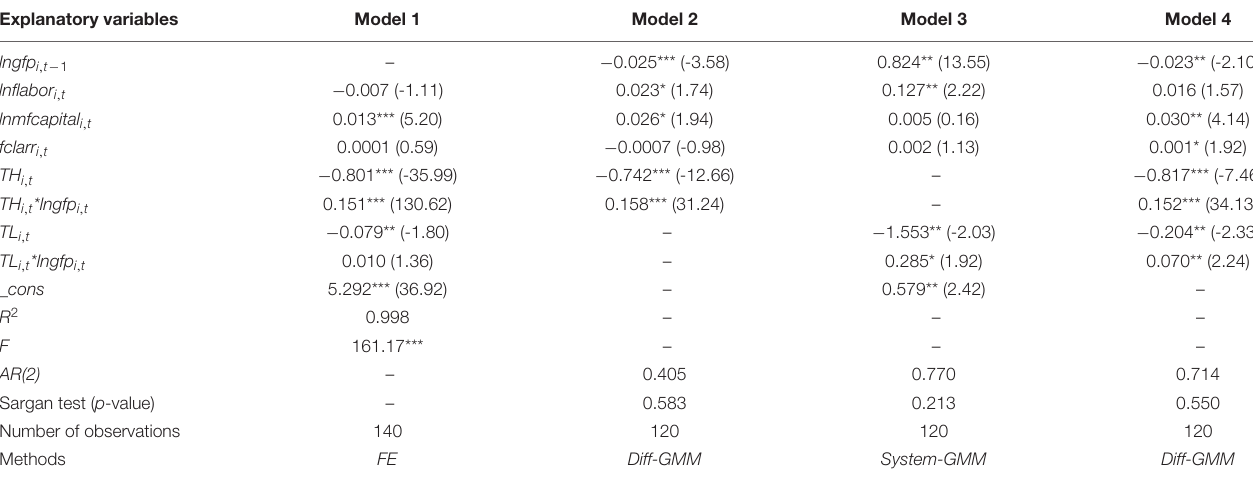
TABLE 1 | Model regression results of regional industrial structure upgrading affecting economic growth of marine fisheries a